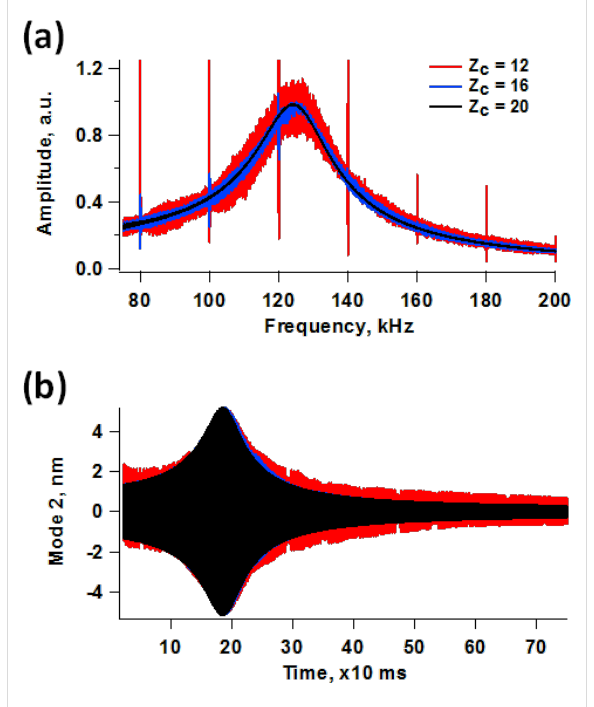
Figure 6: Frequency space (a) and time space (b) responses of the system of Figure 5 for three different cantilever positions above the sample, obtained by sweeping the frequency from low to high using a chirp function while keeping the cantilever at the fixed height indicated. Z c = 20 nm corresponds to the free response. The results shown in (a) were obtained through application of the fast Fourier transform to the results shown in